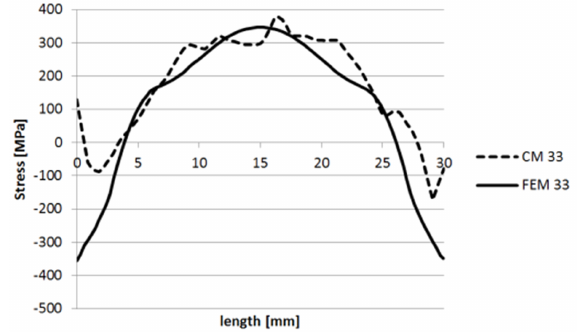
Figure 57. Stress levels in 33 direction along the AB line